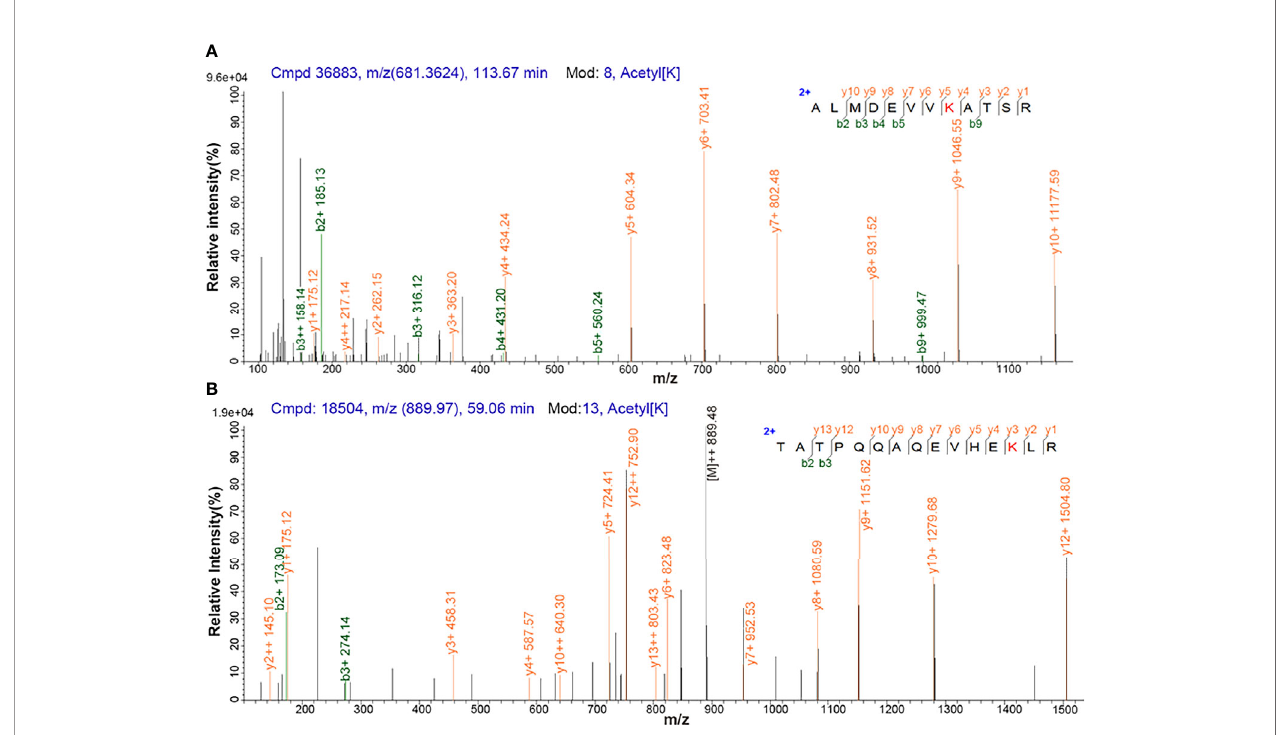
FIGURE 1 | MS/MS spectrum of the tryptic peptide. (A) The tryptic peptide ALMDEVVK*ATSR from PGK1. (B) The tryptic peptide TATPQQAQEVHEK*LR from triosephosphate isomerase. K* = acetylated lysine